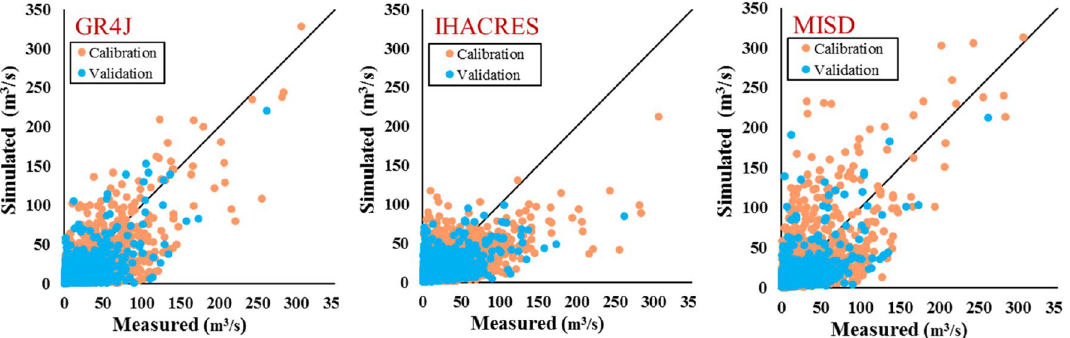
Figure 4. Scatter plots of measured vs simulated runoff using the GR4J, IHACRES and MISD.